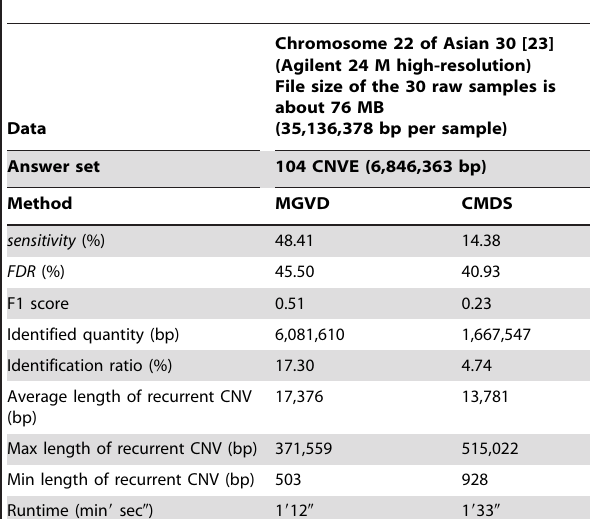
Table 3. Performance comparison of MGVD and CMDS. Table 4. Notations used throughout the